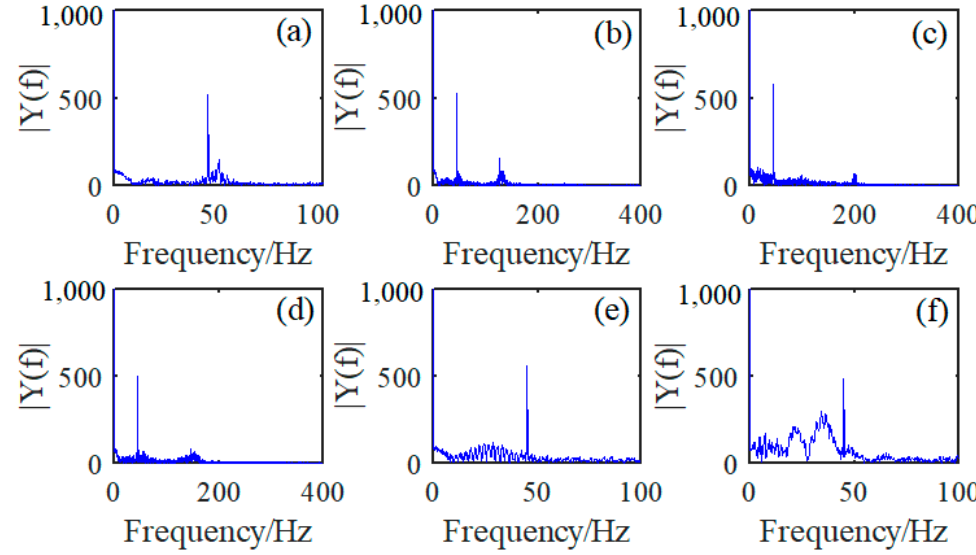
Figure 3. FFT of different wire rope defect signals: ( a ) FFT from defect 1; ( b ) FFT from defect 2; ( c ) FFT from defect 3; ( d ) FFT from defect 4; ( e ) FFT from defect 5; and ( f ) FFT from defect 6.